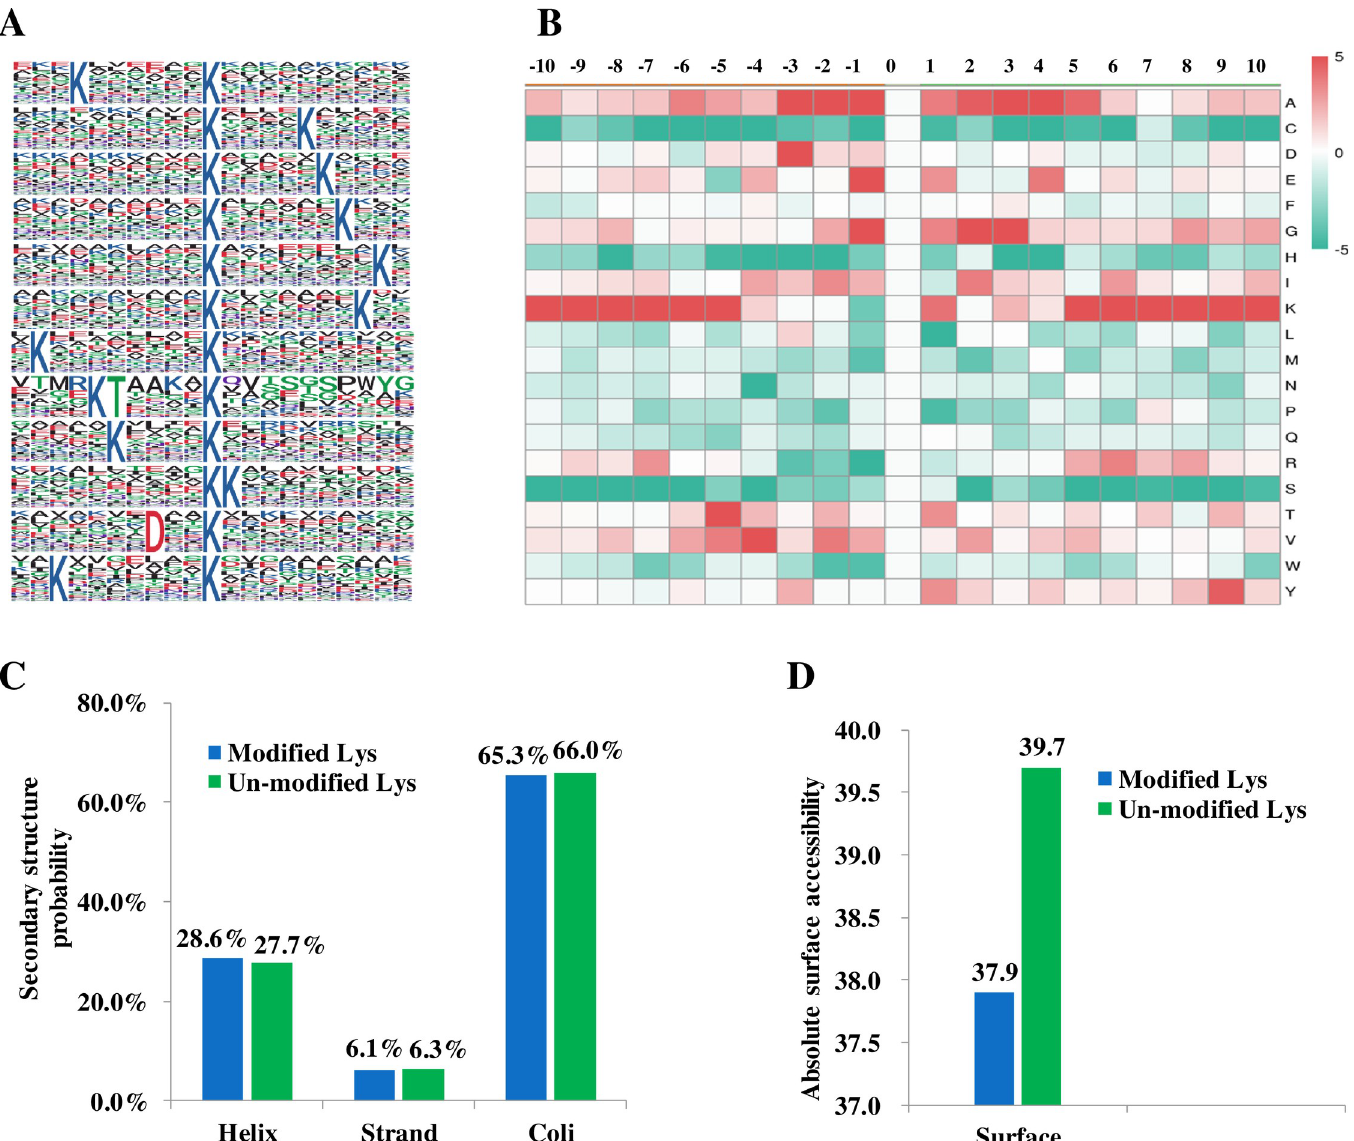
Fig 3. Structure characterizations of all the identified Khib peptides. (A) Motif analysis for amino acids around the Khib sites ( − 10 to +10). The letter height represents the frequency of that amino acid residue at that position. The K in the middle position corresponds to the Khib sites. (B) Heat map analysis of the amino acid compositions around the Khib sites. Red indicates an amino acid that is significantly enriched, while green indicates an amino acid that is significantly reduced. (C) Secondary structure analysis of Khib peptides and (D) Predicted surface accessibility of Khib peptides. Modified sites were marked in blue and unmodified sites were marked in green.